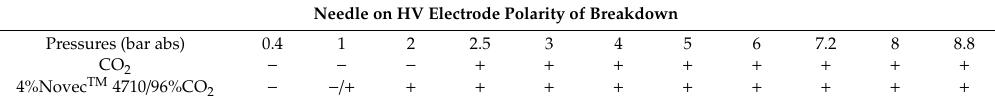
Figure 4. V mean Breakdown, positive and negative inception voltages as a function of gas pressure (CO 2 , needle on HV electrode). Table 2. AC Breakdown polarity of CO 2 and 4%Novec TM 4710 / 96%CO 2 under di ff erent pressures up to 8.8 bar abs (Needle on HV